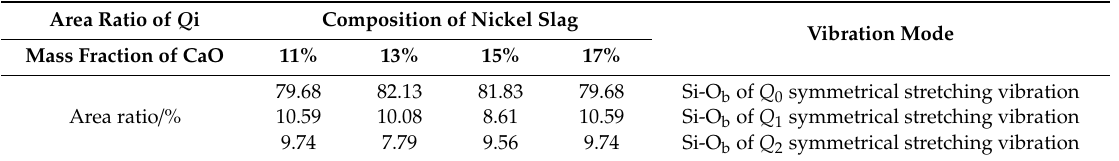
Table 4. Relative ratio of Raman characteristic peaks of nickel slag with different CaO content quenched at 1150 °C.